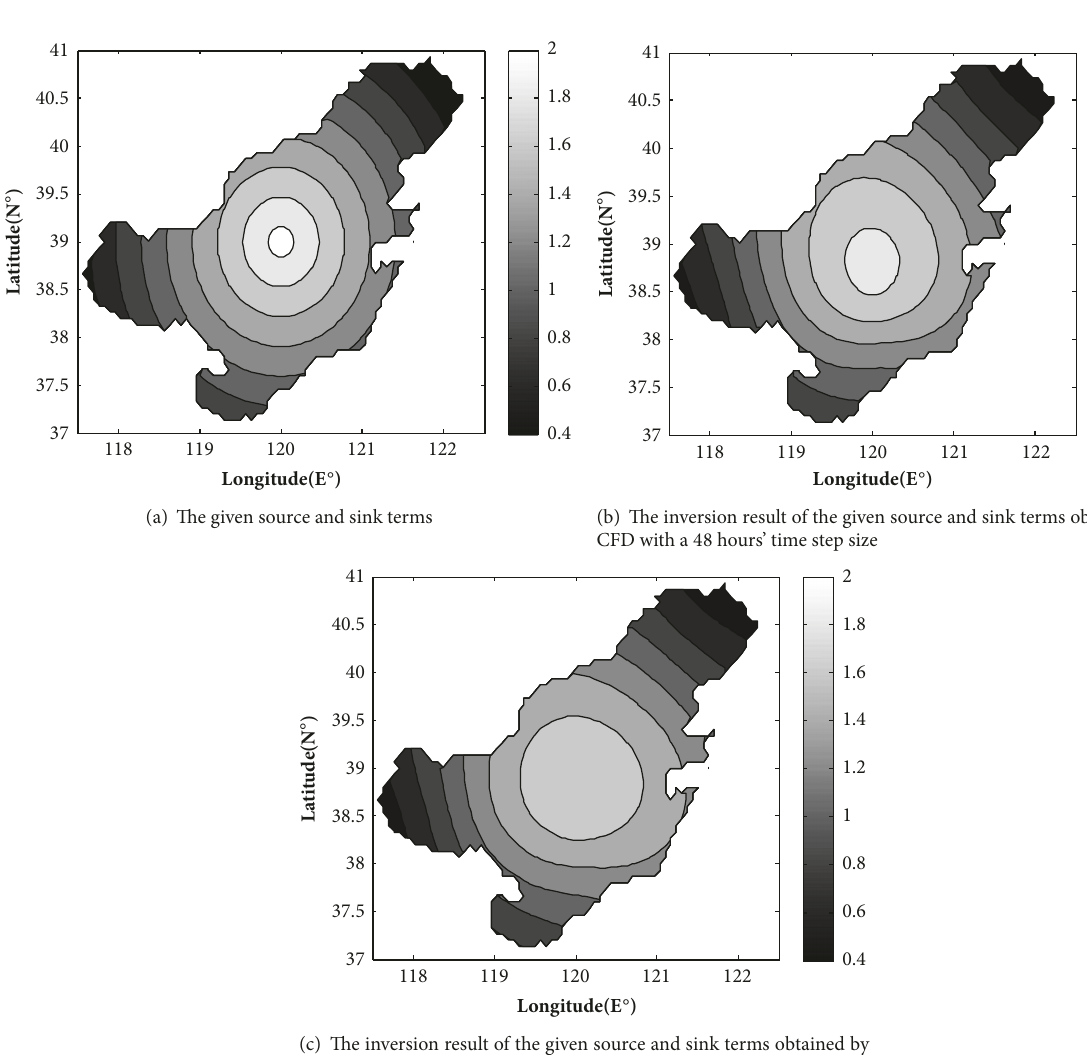
Figure 9: Figures of the source and sink terms inverted by the adjoint method of data assimilation with CFD and CDS.